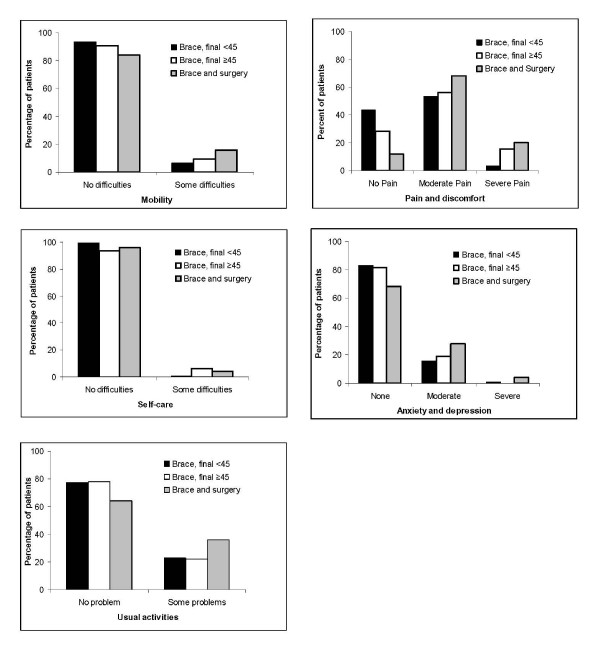
Quality of life at long-term follow-up in late-onset juvenile and adolescent idiopathic scoliosis treated with the Boston brace. Percentages of patients are given for each domain (mobility, pain and discomfort, usual activities, self-care, and anxiety and depression) in patients with brace and final curve < 45°, brace and final curve ≥ 45°, and brace and surgery. Significantly (p < 0.01) more patients in the two latter groups reported moderate and severe pain.